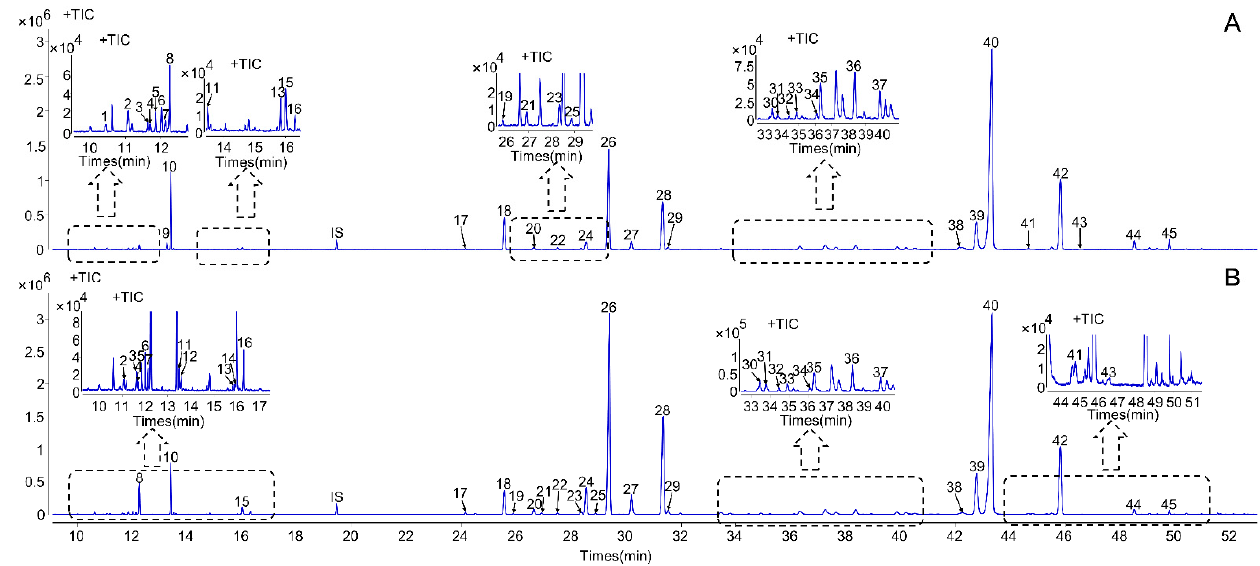
Figure 1. The GC–MS total ion chromatograms of the RCL ( A ) and RHCL ( B ) volatile oils (peak IS represented the internal standard). Table 1. Chemical constituents in RCL and RHCL volatile oils were identified by GC–MS.